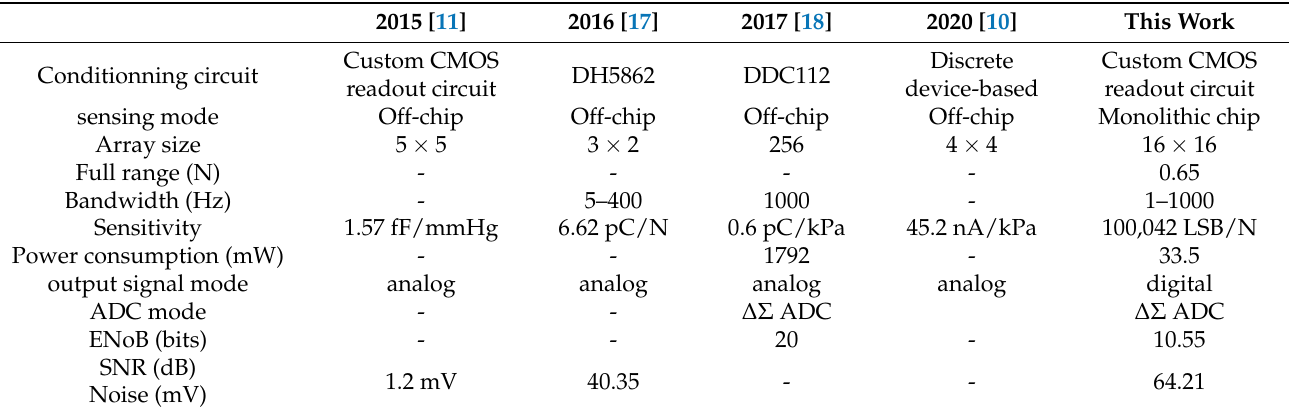
Table 1. Comparison with other state-of-the-art tactile